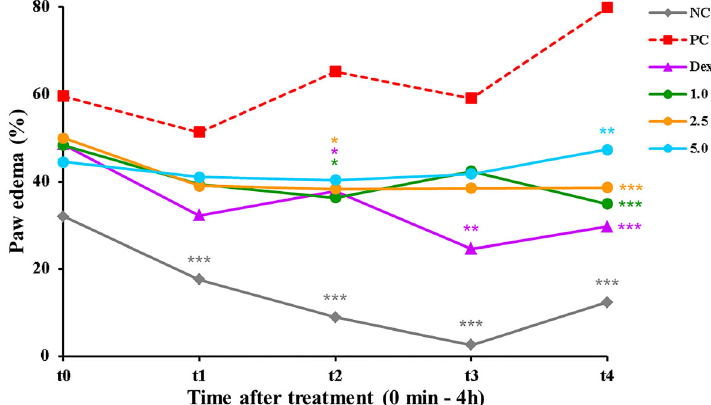
Figure 3. Effect of COPHCT in the paw edema assay induced by the subplantar injection of carrageenan in the hind paw of the mice. Data are reported as means ± SE of 5 animals per group. *P o 0.05, **P o 0.01, and ***P o 0.001 compared to the Positive Control group, determined by analysis of variance (ANOVA) followed by Bonferroni post-hoc test. Groups: NC (Negative Control: PBS, sp + PBS 10.0 mL/kg, ig ); PC (Positive Control: carrageenan 1.0%, sp + PBS 10.0 mL/kg, ig ); Dex (carrageenan 1.0%, sp + 2.0 mg/kg dexamethasone, ig ); 1.0, 2.5, and 5.0 (carrageenan 1.0%, sp + COPHCT at 1.0, 2.5, and 5.0 mg/kg, ig